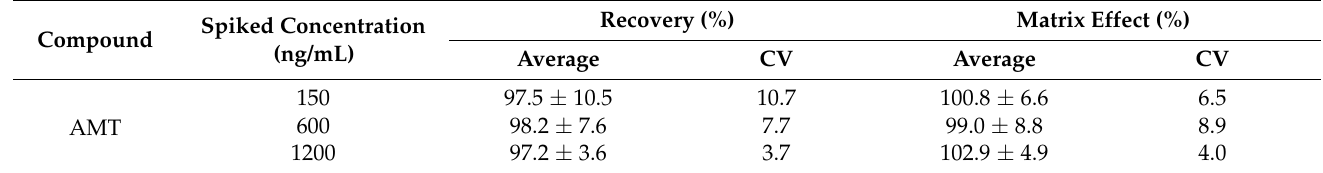
Table 3. Extraction recoveries and matrix effects of AMT in human plasma (n = 6).